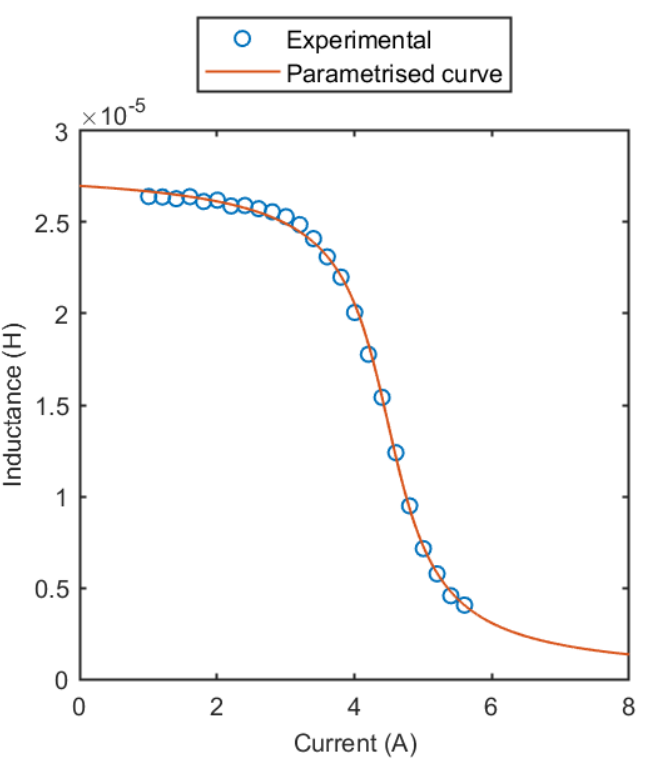
Figure 4. Fitting of the parametrized characteristic on the experimental differential inductance curve for the Coilcraft MSS1260T-273 inductor.